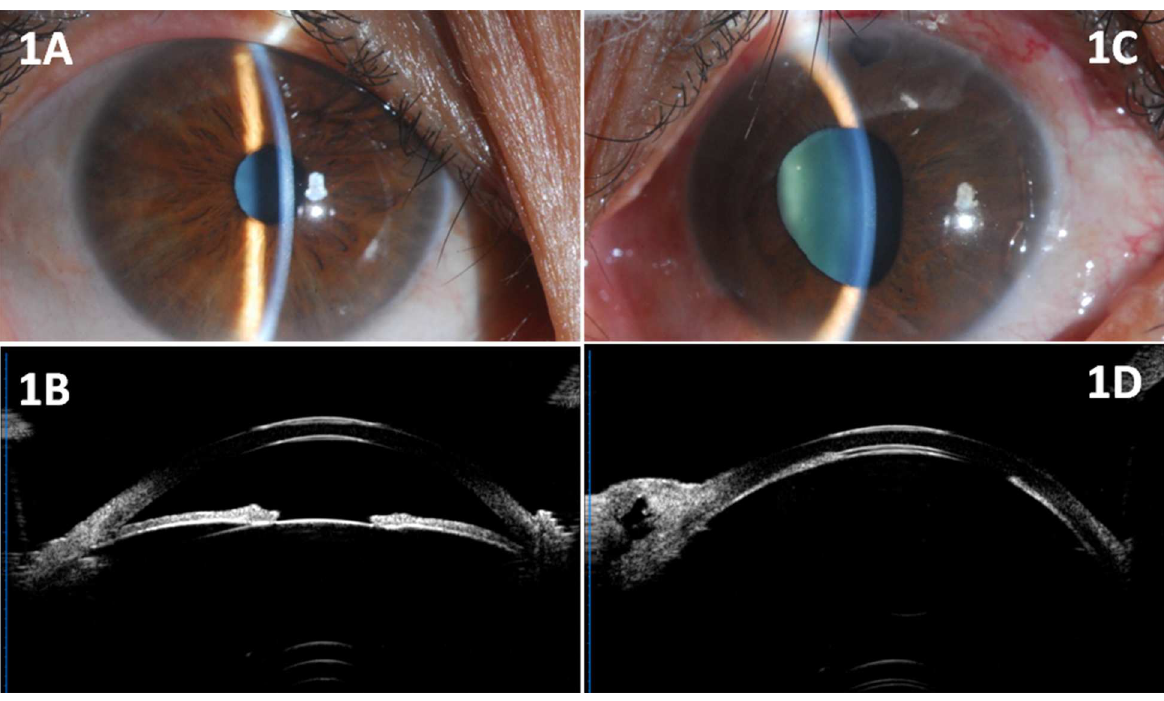
Fig 1. Anterior segment photograph and UBM images of a 46-year-old female patient. (1A, 1B) Photograph andUBM showed relatively shallowanteriorchamberof the righteye. (1C) Colorphotographshowedflat anteriorchamberandmoderatelydilatedpupilof the left eye. (1D) UBM findingsshowedflat anteriorchamber (nearlycorneo-lenticulartouch)in the left eyeonemonthafter trabeculectomy.